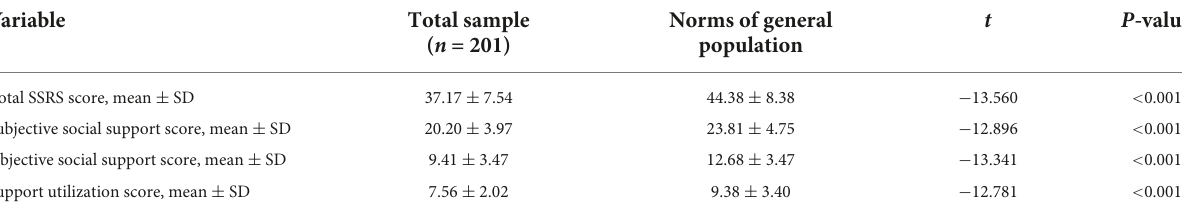
TABLE 2 The difference of social support scores among frontline healthcare workers and the norms of Chinese general population. Variable Total sample ( n =